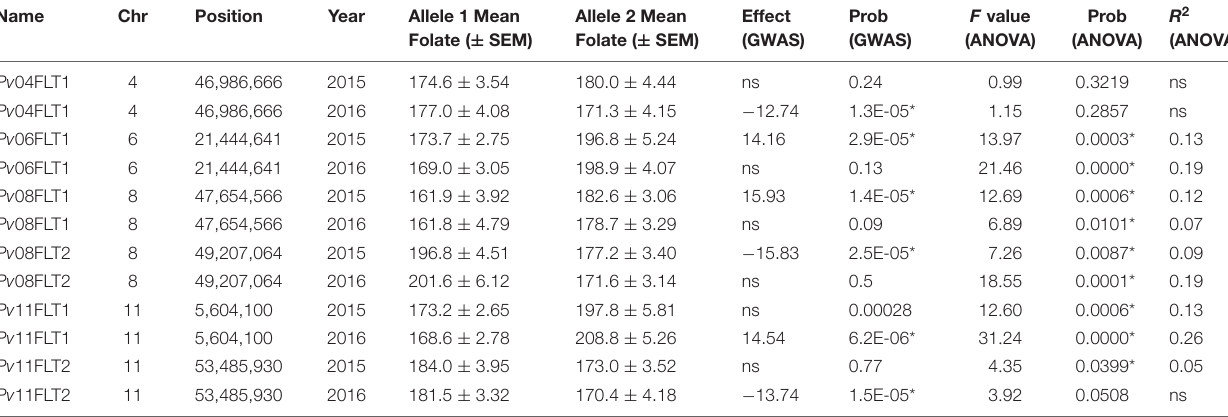
TABLE 2 | QTL for total seed folate content identified by GWAS.